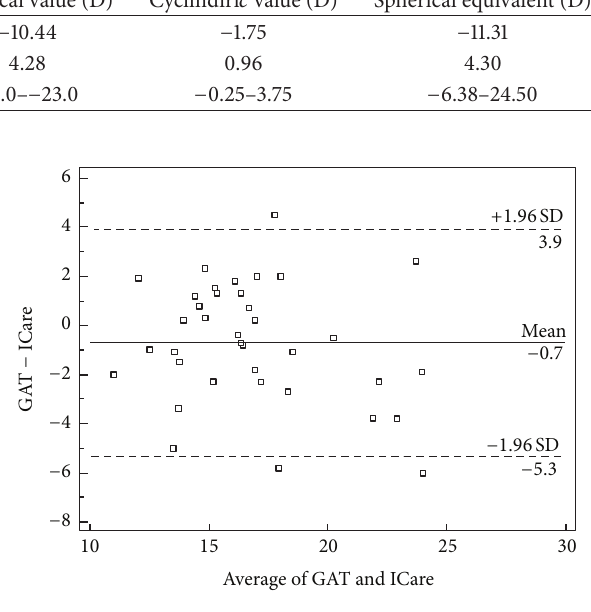
Figure 2: Bland-Altman analysis showing the distribution of dif- ferences in IOP (GAT tonometer value minus RBT value, mmHg) ( 𝑦 -axis) and the mean IOP value of the tonometers ( 𝑥 -axis) for each eye